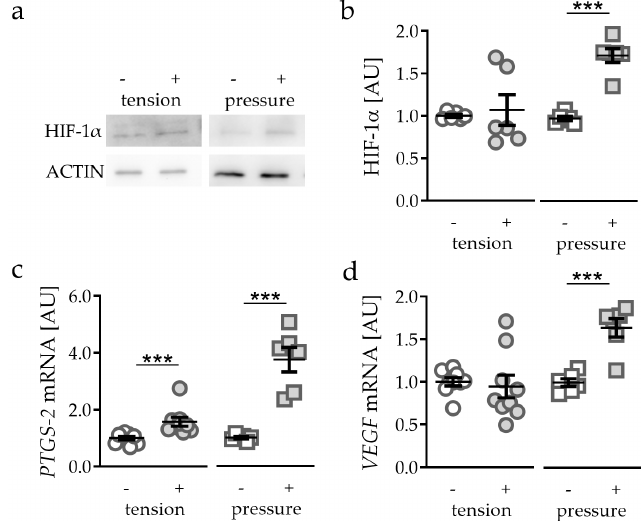
Figure 1. Effects of tensile strain and compressive strain on HIF-1 α protein expression ( a , b , n = 6) as well as PTGS-2 ( c ) and VEGF ( d ) gene expression (n > 6). Statistics: unpaired, two-sided Mann–Whitney U or Student’s t-tests; AU = arbitrary units; *** p <